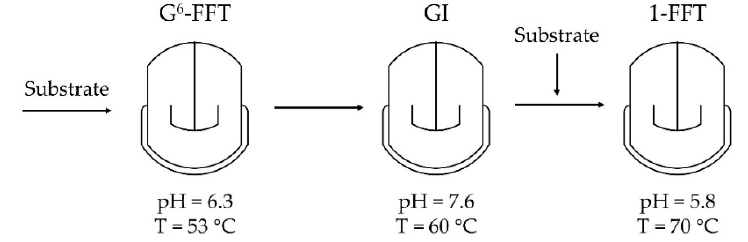
Figure 12. Process scheme of the 2-step neoFOS production in 100 mL scale.